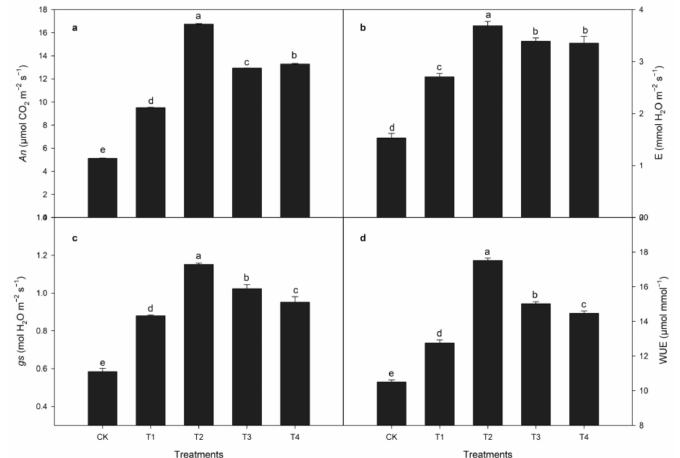
Figure 3. Effects of calcium treatment during heat stress on the ( a ) net photosynthetic rate ( An ); ( b ) transpiration rate (E); ( c ) stomatal conductance ( gs ); and ( d ) water use efficiency (WUE) in rose plants treated with 50 µ M CaCl 2 (T1), 100 µ M CaCl 2 (T2), 150 µ M CaCl 2 (T3), 200 µ M CaCl 2 (T4) or H 2 O as the control (CK). Each vertical line shows the standard error ( n = 10). The values are described as means ± SD; different letters denote significant differences ( p < 0.05) according to Duncan’s multiple range